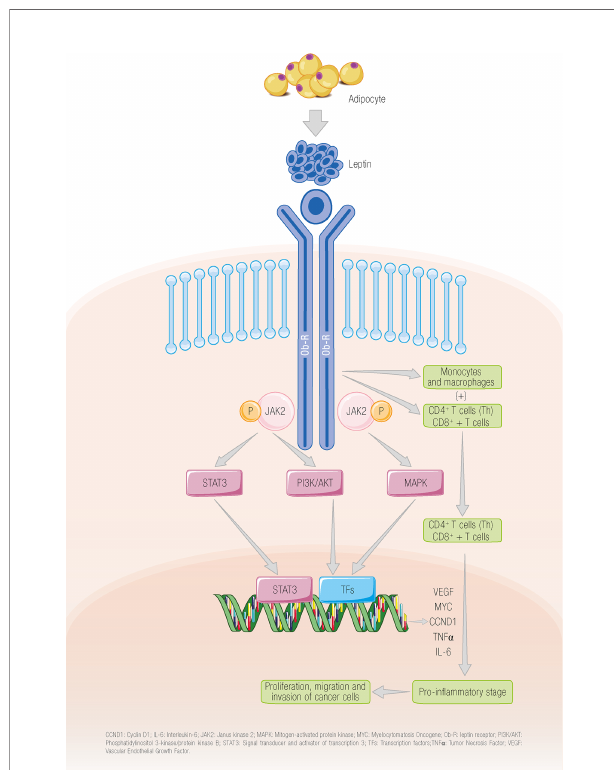
FIGURE 1 | The binding of leptin to its receptor leads to the activation of different signaling pathways. Leptin binds to its receptor on the tumor cell, promoting the activation of different signaling pathways that, in turn, lead to the proliferation and invasion of tumor cells. The leptin receptor can also be located on different cells of the adaptive system leading to activation of these cells (34 – 37). CCND1, cyclin D1; IL-6, interleukin 6; JAK2; Janus kinase 2; MAPK, mitogen-activated protein kinase; MYC, myelocytomatosis oncogene; Ob-R, leptin receptor; PI3K/AKT, phosphatidylinositol 3 kinase/protein kinase B; STAT3, signal transducer and activator of transcription 3; TFs, transcription factors; TNF a , tumor necrosis factor alpha; VEGF, vascular endothelial growth factor. Garc ı ́ a-Este ́ vez L ©